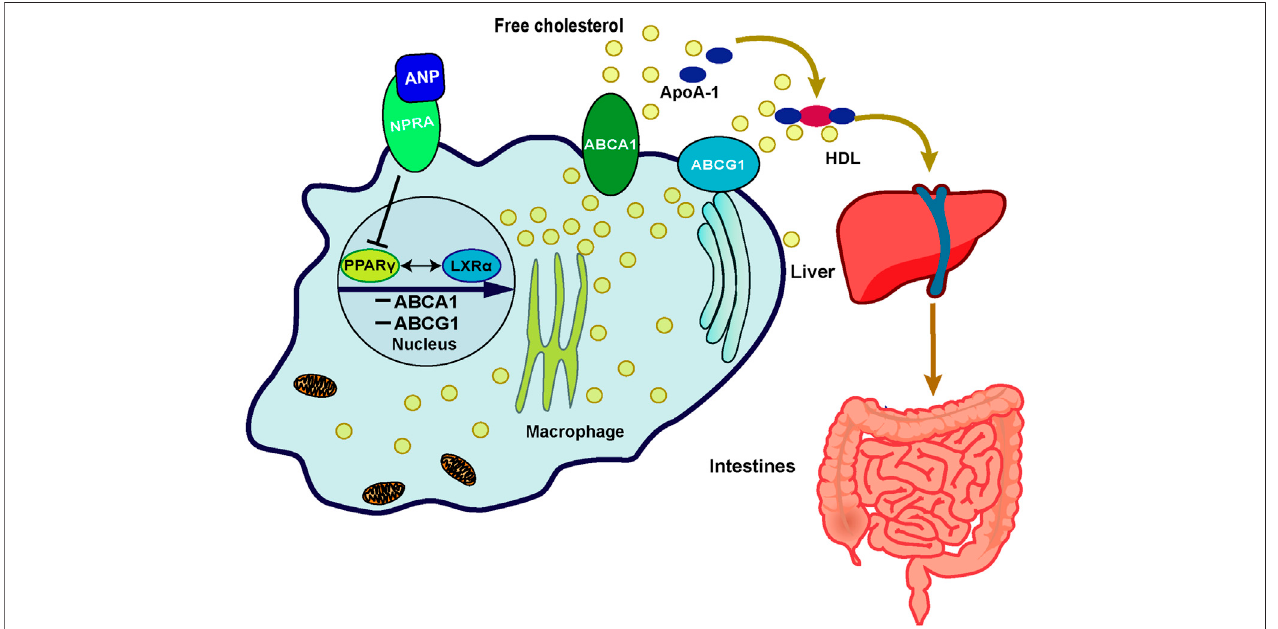
FIGURE 5 | Schematic representation of the possible mechanism of ANP on the cholesterol ef fl ux mediated by the PPAR γ /LXR α – ABCA1/ABCG1 signaling pathway in macrophages. In the THP-1 derived macrophages, ANP inhibited the transcription of PPAR γ and LXR α , then the expression of ABCA1 and ABCG1 was inhibited, thereby inhibiting cholesterol ef fl ux from macrophages to apoA-I and HDL mediated by ABCA1 and